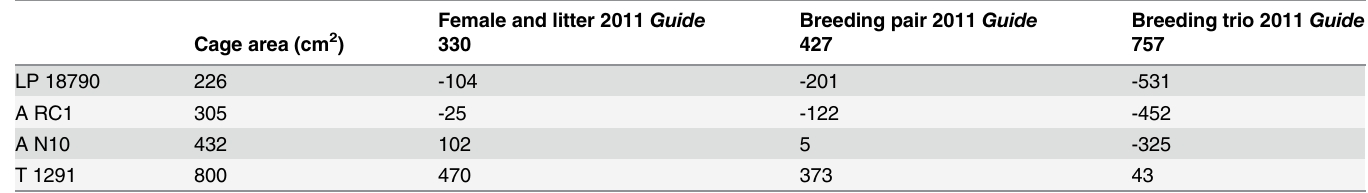
Table 2. Differences between cage area provided in this study and the amount of space recommended by the 2011 Guide